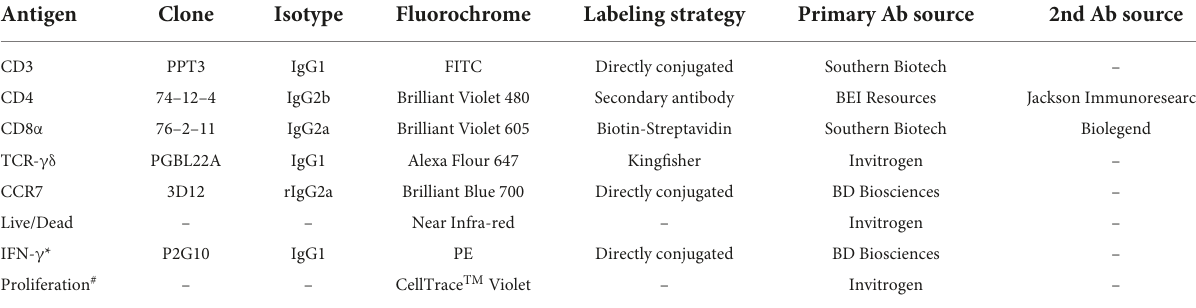
Table 1 . Flow cytometry data were acquired on a Cytoflex using the CytExpert software (Beckman Coulter). Data analysis was performed with FlowJo version 10.5.3 (FLOWJO LLC) with gates based upon relevant FMO controls. TABLE 1 Flow cytometry staining